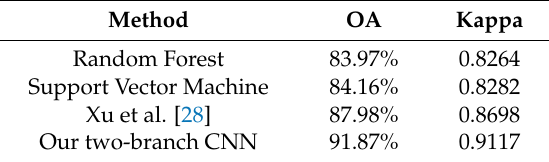
Table 7. Accuracy comparison with other